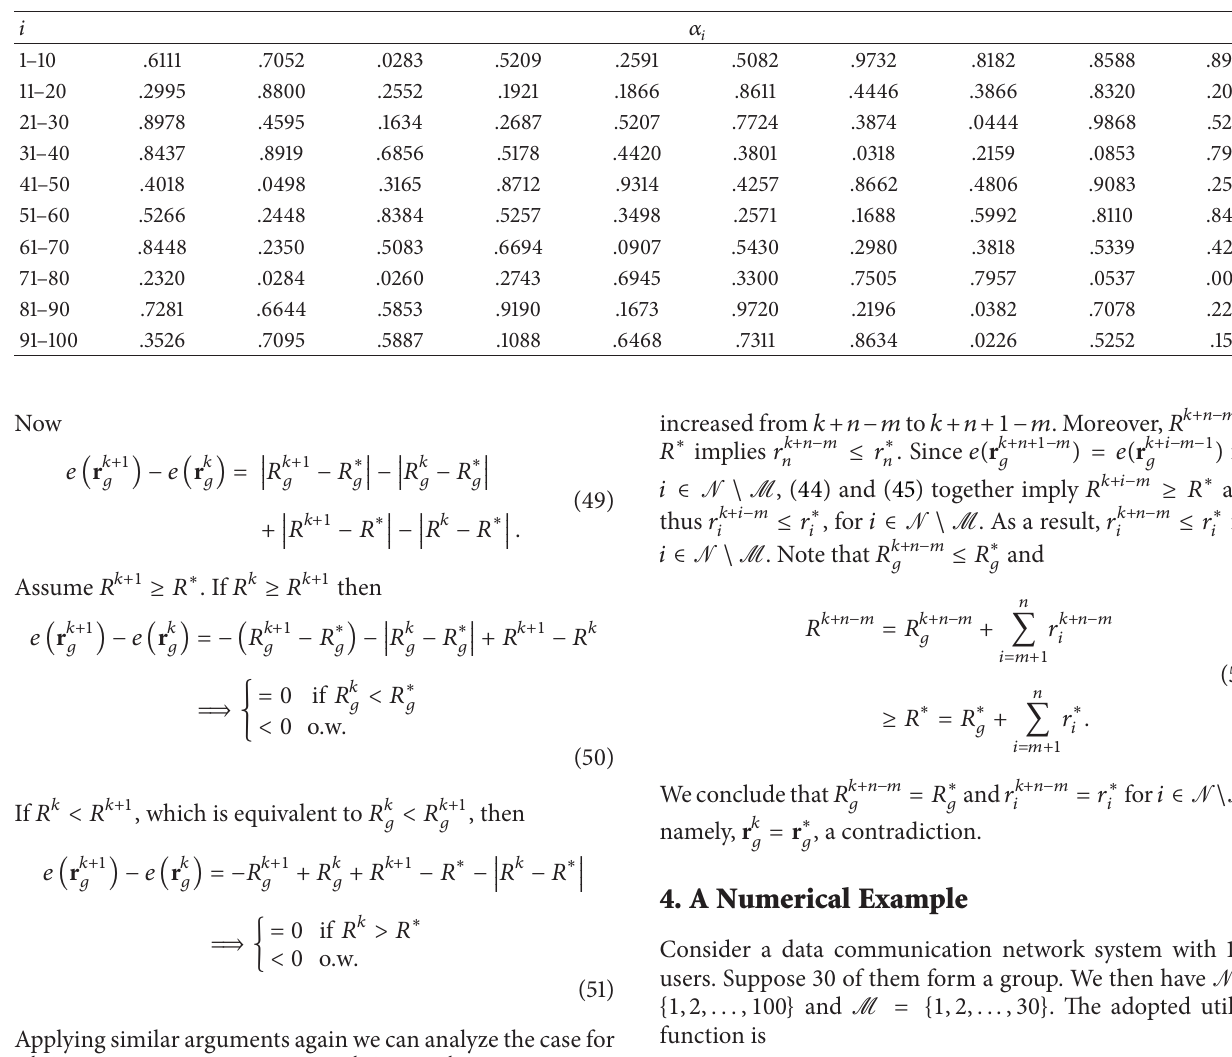
Table 1: The parameters of 𝛼 𝑖 for 𝑖 ∈ N = {1, 2, .. ., 100}